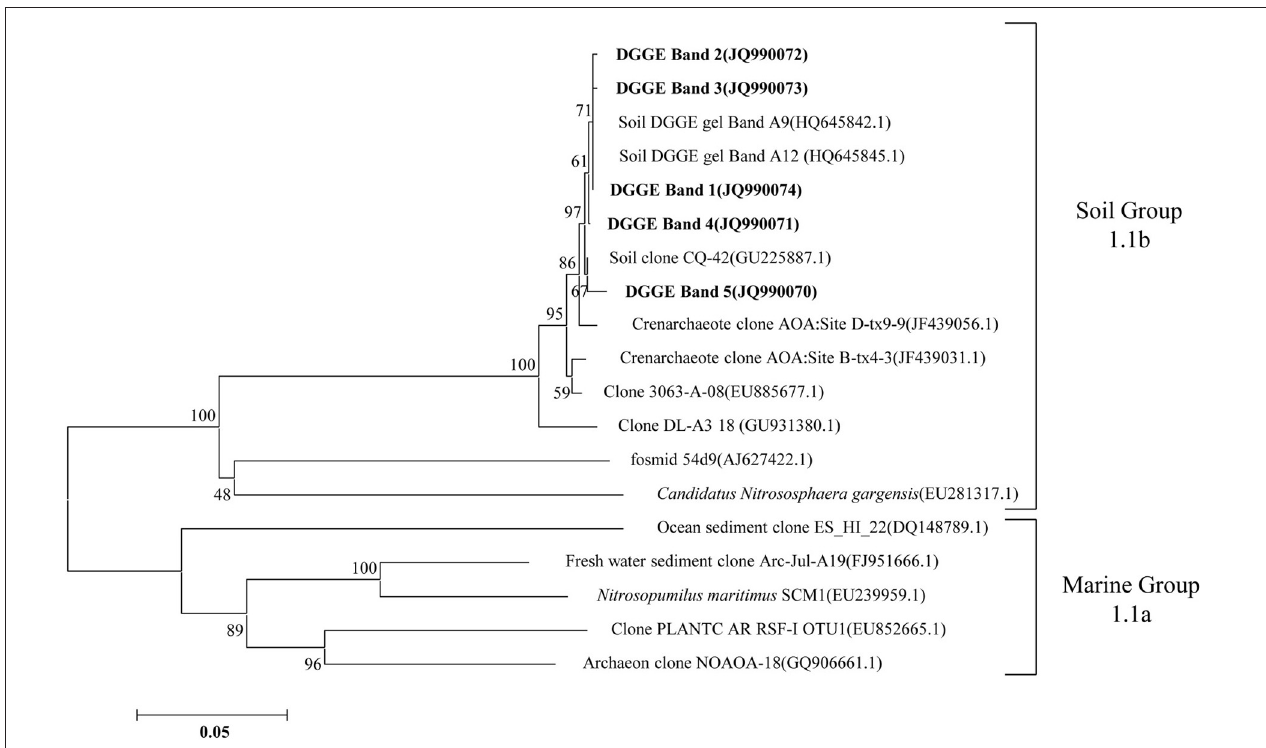
FIGURE 8 | Neighbor-joining tree showing the relationships of the archaeal amoA genes retrieved from the DGGE bands (bold) in this study to those in the GenBank. The scale bar indicates 5 changes per 100 nucleotide acid positions. Bootstrap values ( > 40%) are indicated at branch